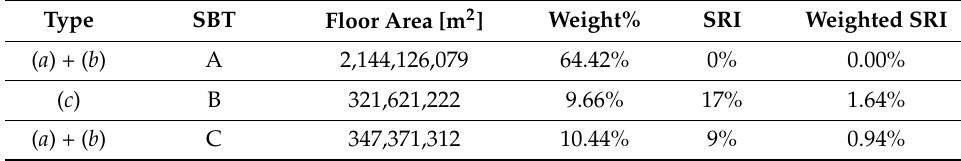
Table 8. SRI of the national building stock (base